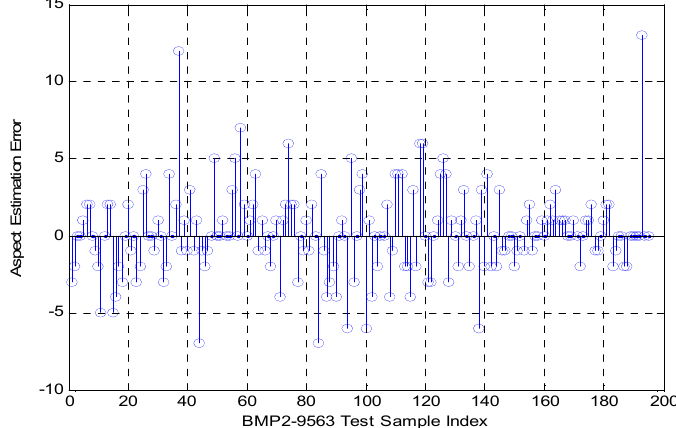
Figure 5. Estimation error in aspect angle of all testing samples of BMP2-9563.